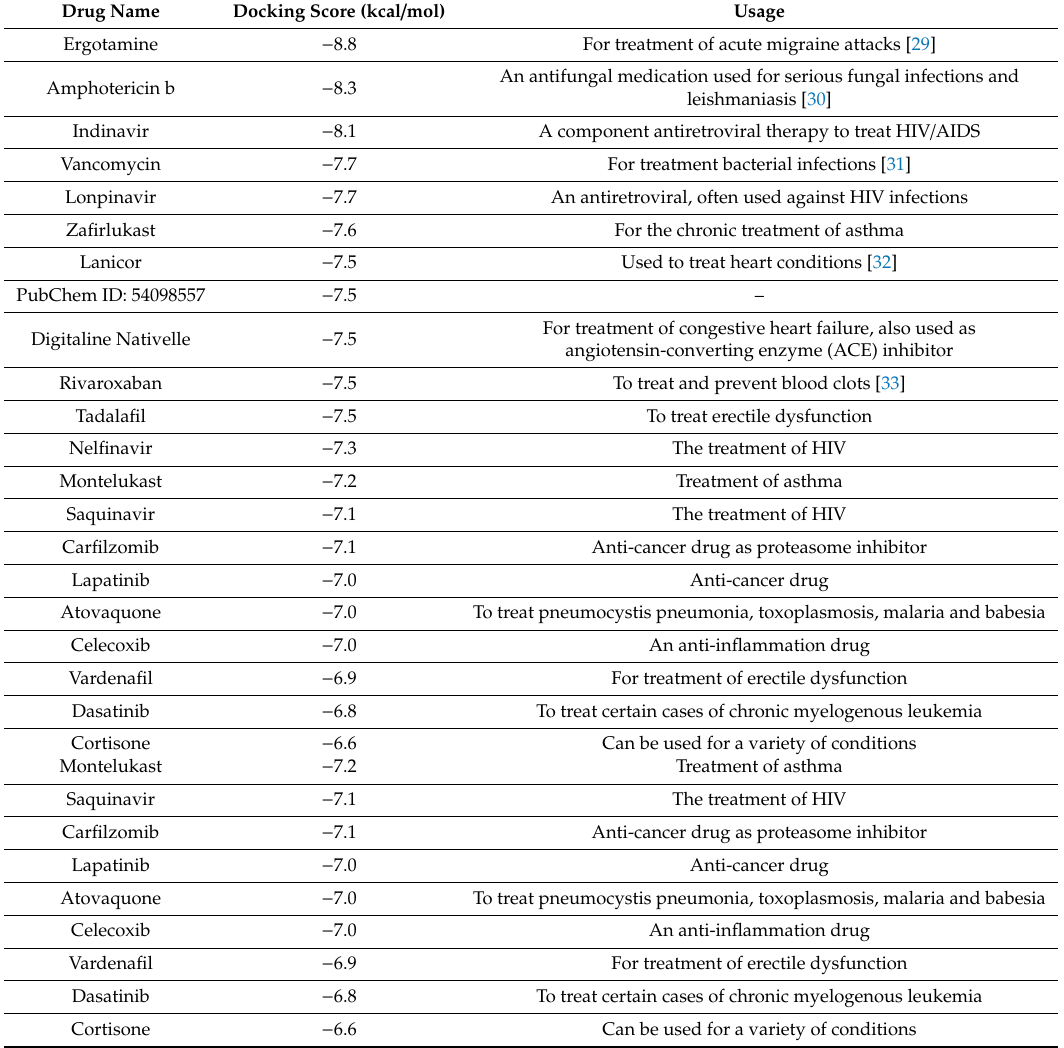
Table 2. Di ff erent docking scores of ligands for the SARS-CoV-2